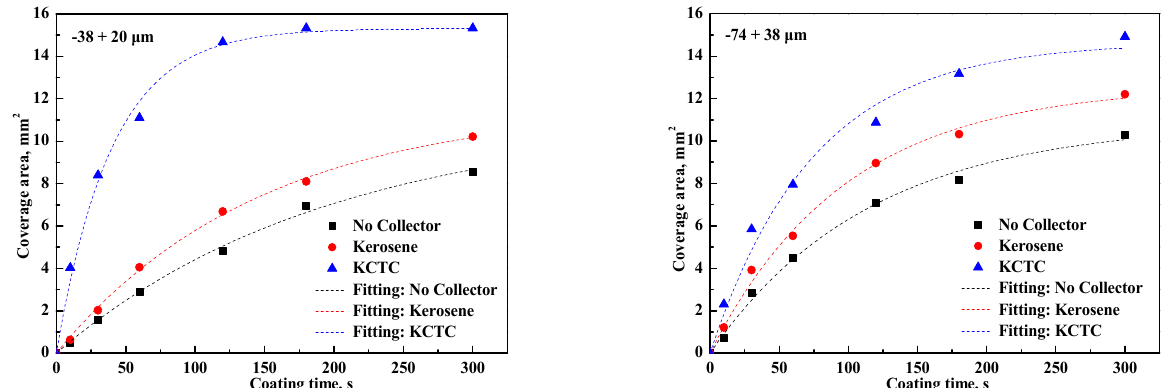
Figure 7. Attaching kinetics fitting of molybdenite particles to bubbles, using a classical first ‐ order model. Figure 6. Surface coverage of bubbles with different molybdenite powders, as the function of different collectors.